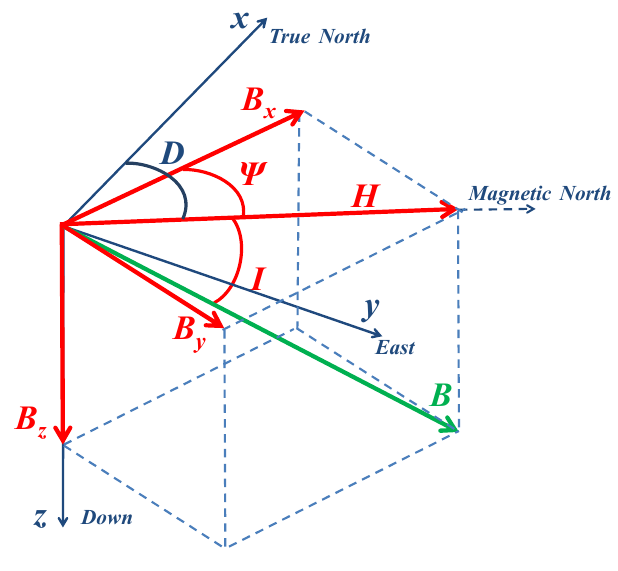
Figure 1. Earth’s magnetic field in Cartesian coordinate